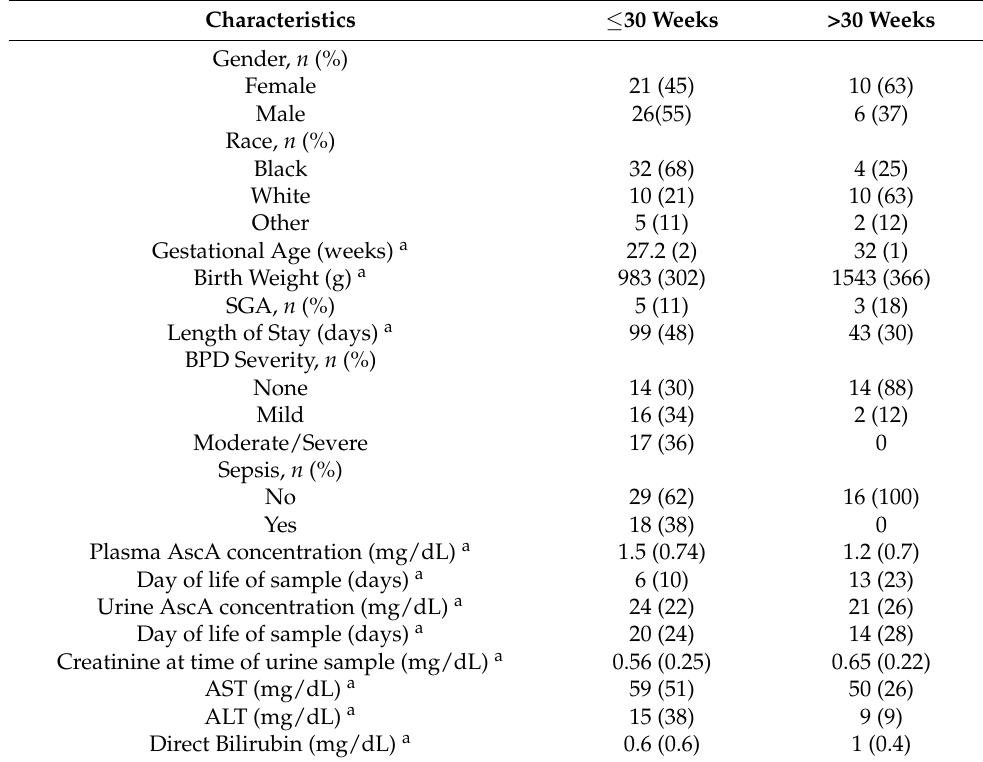
Table 6. Patient characteristics ≤ 30 weeks ( n = 47) vs. >30 weeks ( n =